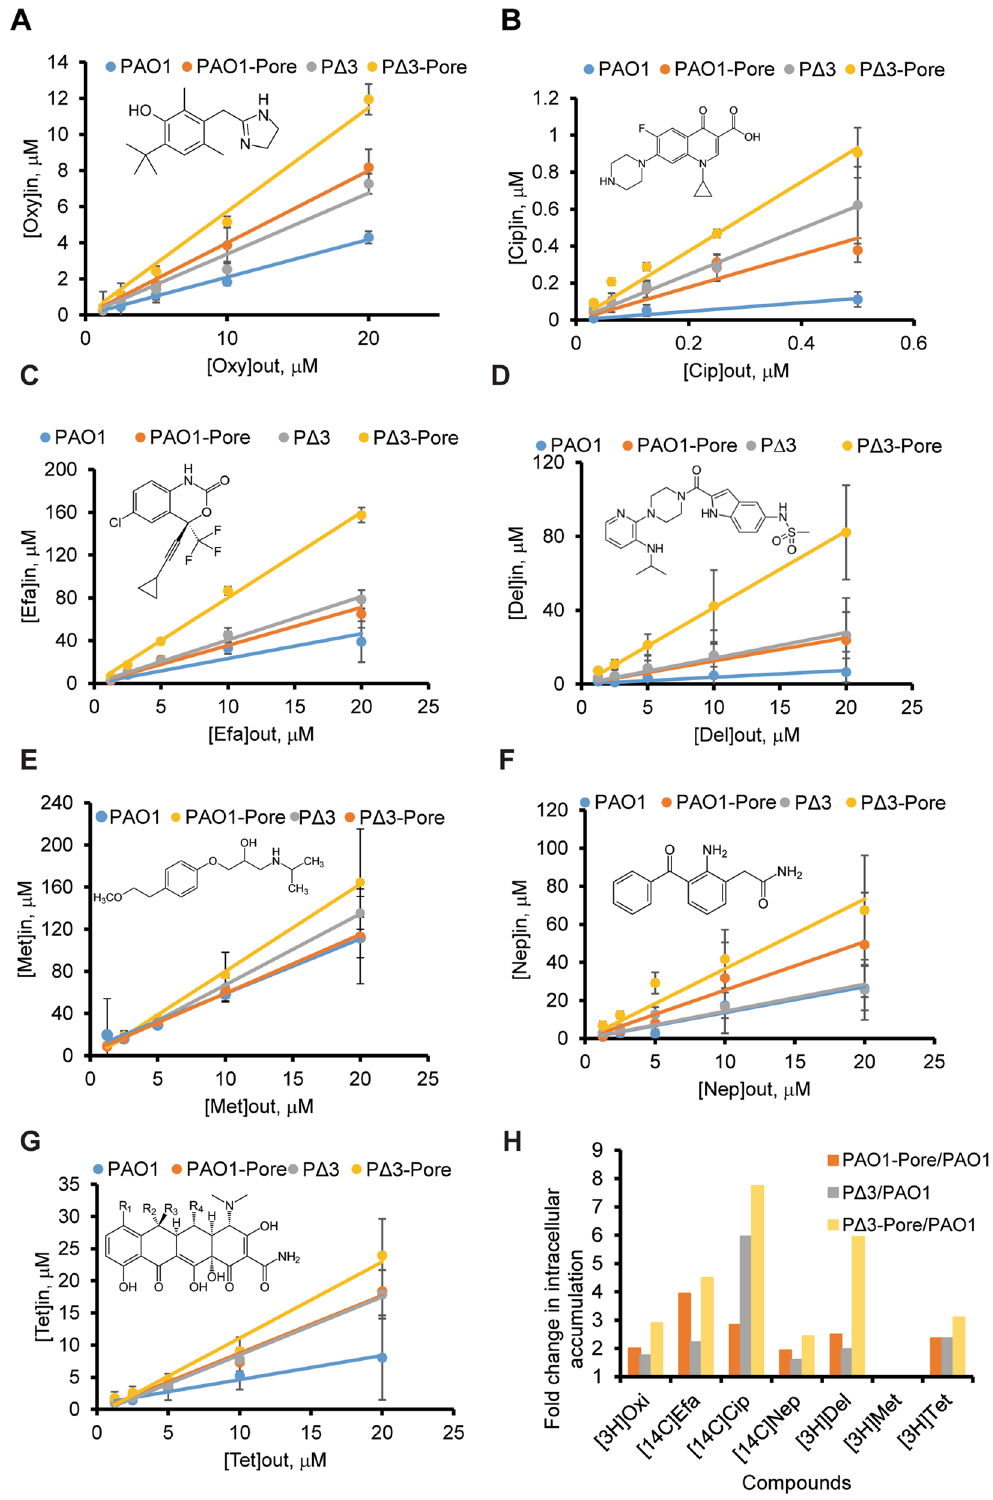
Figure 1. Intracellular accumulation profiles of radioactively labeled compounds in four strains of P. aeruginosa after 20 min of incubation: ( A ) [ 3 H]-oxymetazoline (Oxy); ( B ) [ 14 C]-ciprofloxacin (Cip); ( C ) [ 14 C]-efavirenz (Efa); ( D ) [ 3 H]-delavirdine (Del); ( E ) [3H]-metaprolol (Met); ( F ) [ 3 H]-nepafenac (Nep); G . [ 3 H]-tetracycline (Tet). Extracellular (out) and intracellular (in) concentrations were calculated based on specific radioactivities of compounds. ( H ) Fold change (represented as slope ratios) in the intracellular accumulation of compounds in hyperporinated, efflux-deficient and “barrierless” cells in comparison to the wild type